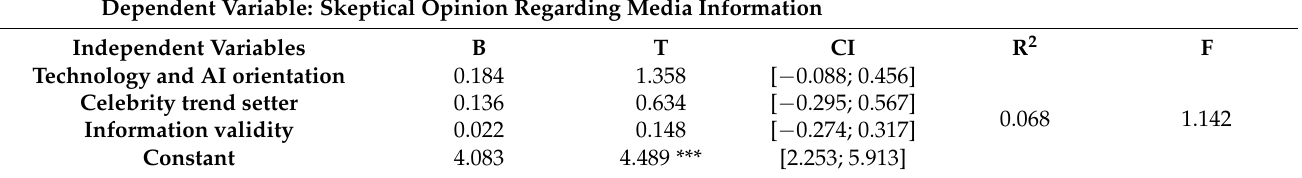
Table 4. Regression model for cluster 2.